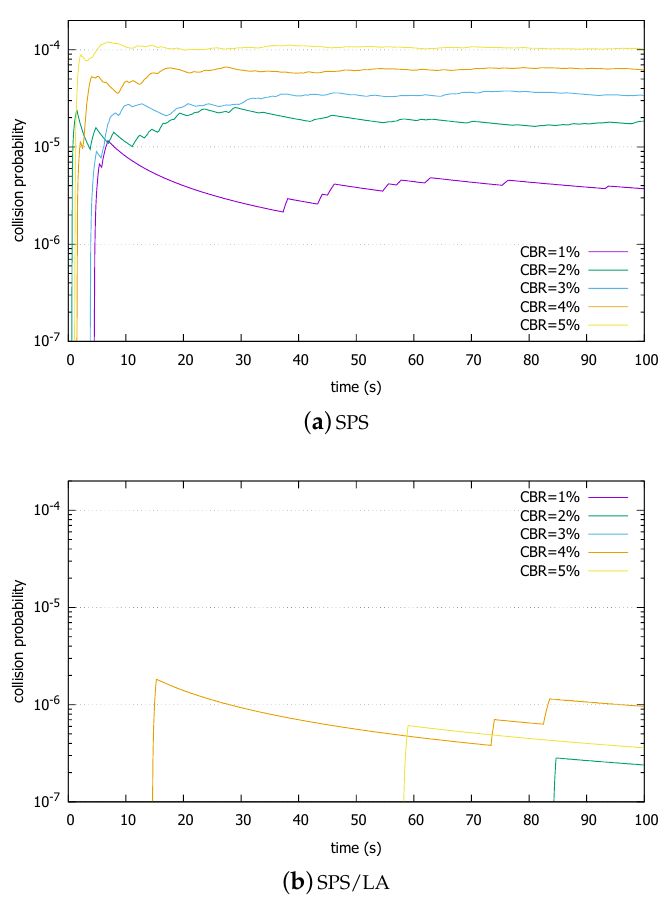
Figure 7. Packet collision rates comparison in ( a ) SPS and ( b ) SPS/LA, light